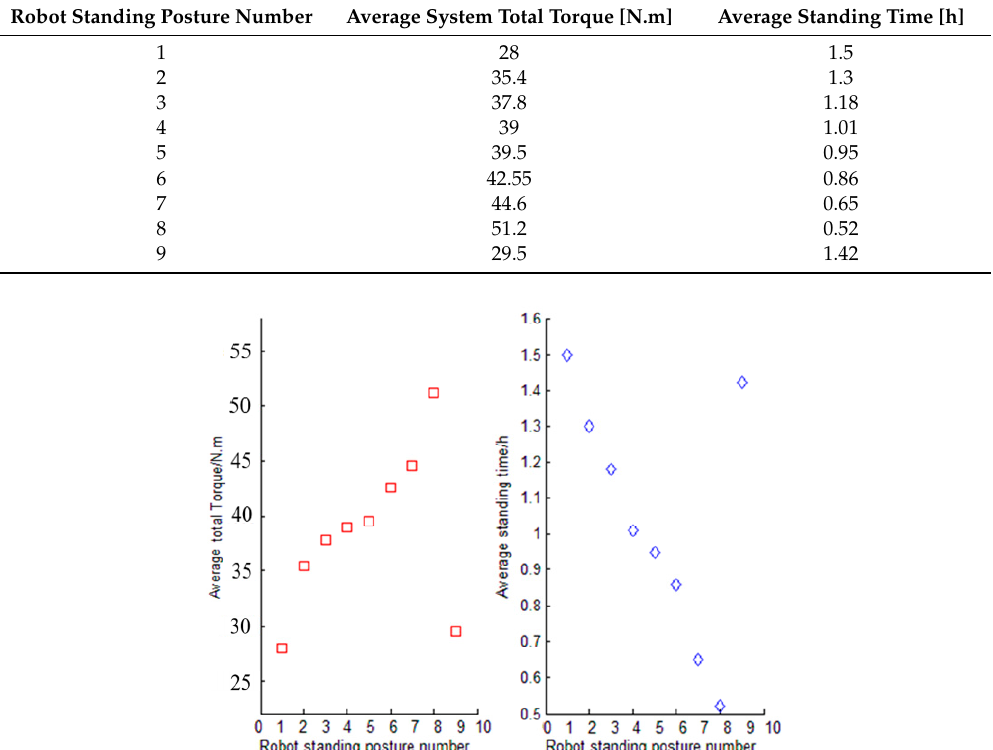
Table 7. Data of Figure 16.